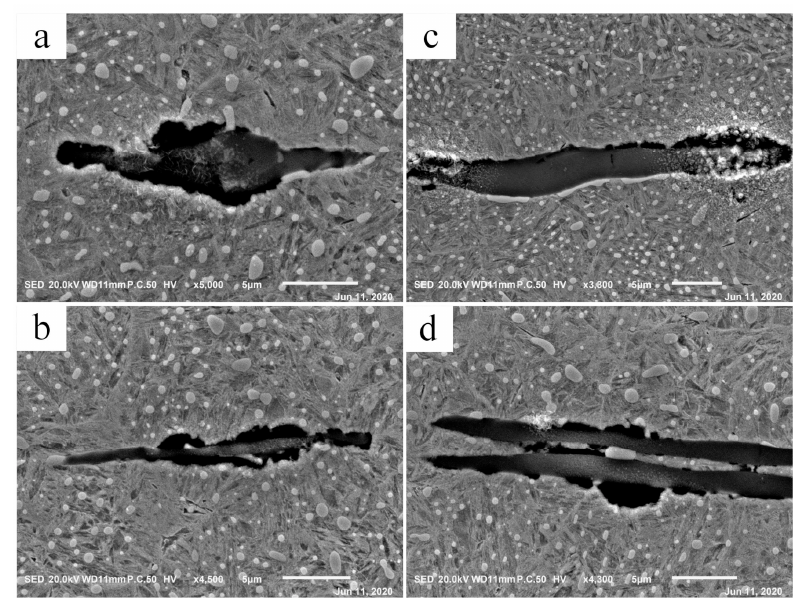
Figure 15. Separation of inclusions from matrix in cylindrical specimen. ( a – d ) Specific examples observed by SEM.